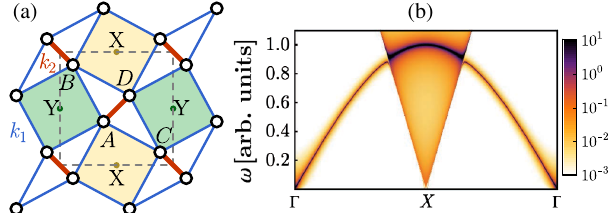
FIG. 15. (a) A , B , C , and D label four copper sites in each unit cell (marked out in dashed lines). k 1 and k 2 are the stiffnesses of the two types of bonds (nearest neighbor and dimer). X and Y label the two types of plaquettes. (b) Schematic illustration of the phonon spectrum. A continuum emerges at the X point due to the VBS-phonon